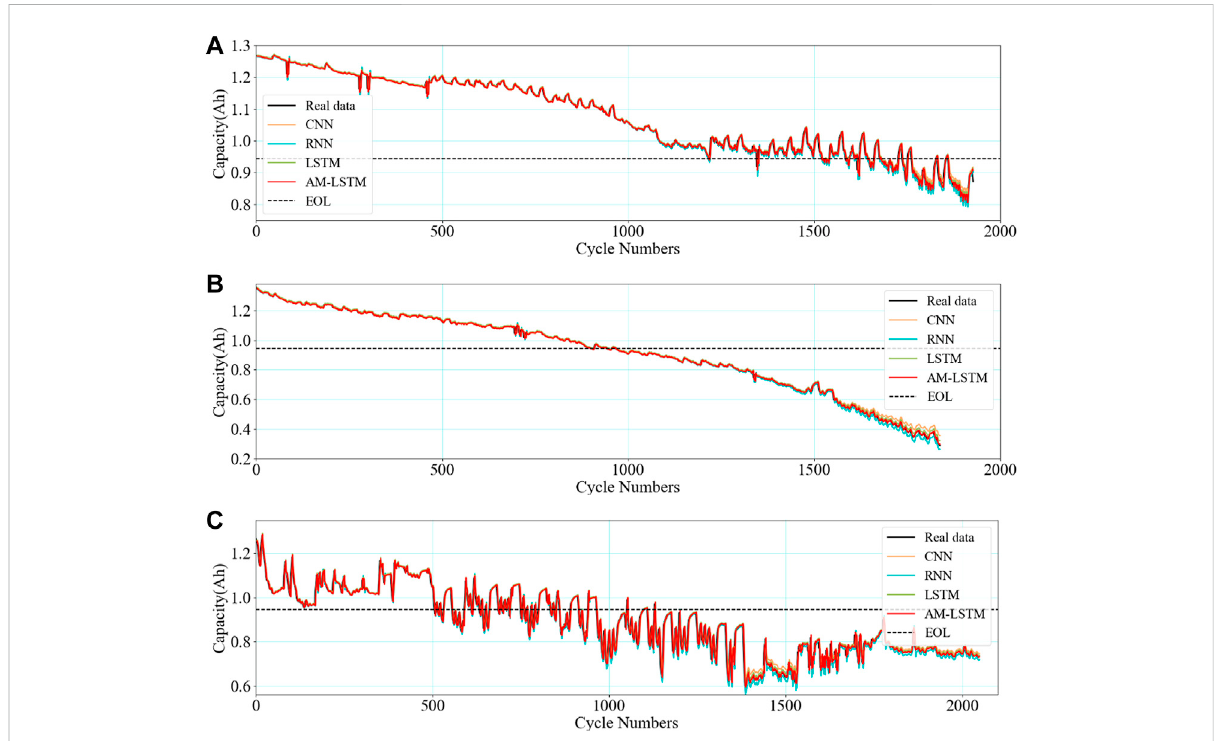
FIGURE 7 The capacity prediction results of the proposed method for different discharge rates of batteries compared with three other kinds of neural networks: (A) the capacity prediction result for CX16 battery with a discharge rate of 0.5C; (B) the capacity prediction result for CX38 battery with a discharge rate of 1.0C; (C) the capacity prediction result for CX8 battery with a discharge rate of